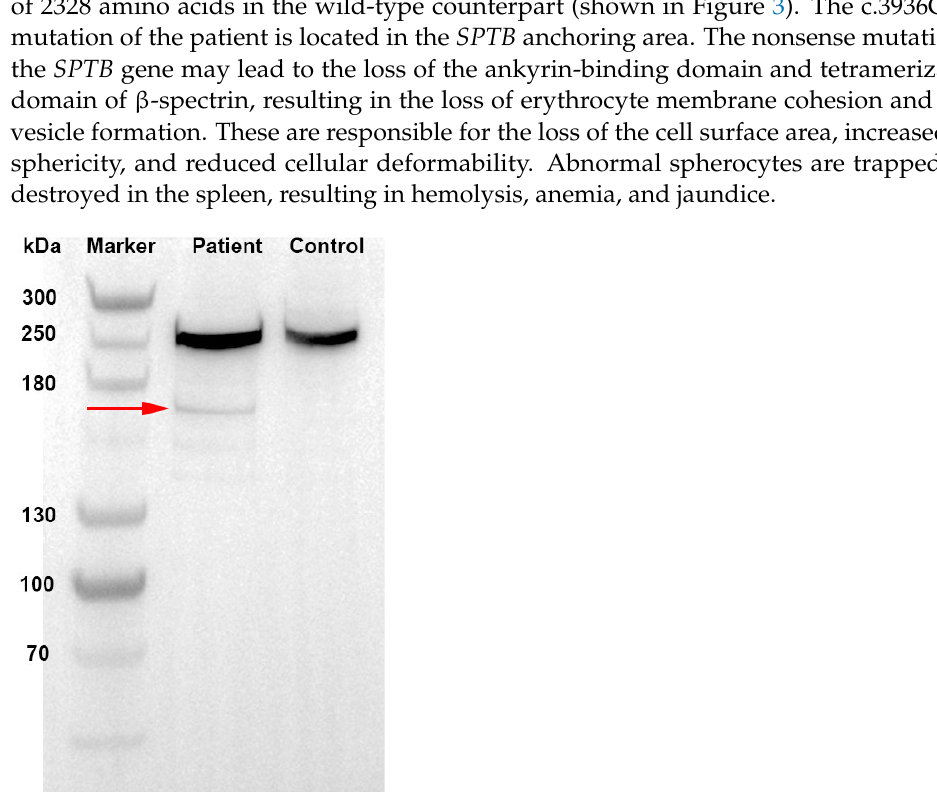
Figure 3. Western blot-based detection of β -spectrin: red arrow showed the truncated β -spectrin. The SPTB gene mutations were classified into autosomal dominant (AD) inheritance.